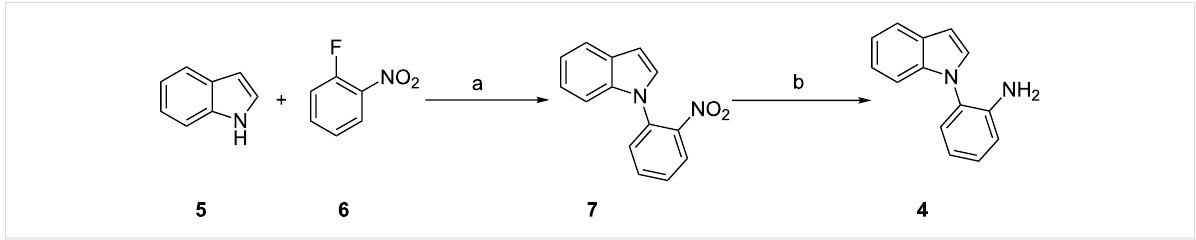
such as salicylaldehyde with tryptophan methyl ester or